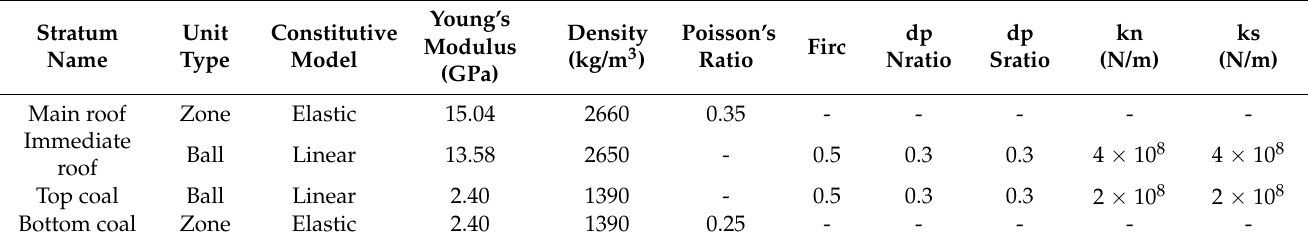
Table 3. Numerical parameters [2,8,21].